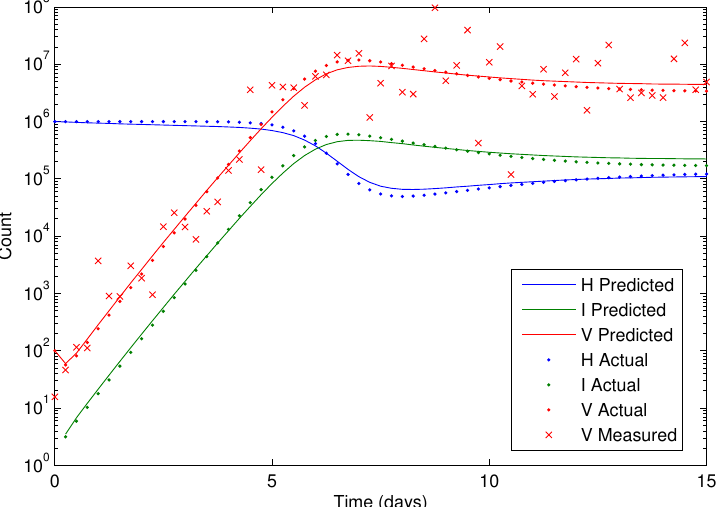
Figure 8. Results of the HIV model parameter estimation, including predicted, actual, and measured virus (V), infected cells (I), and healthy cells